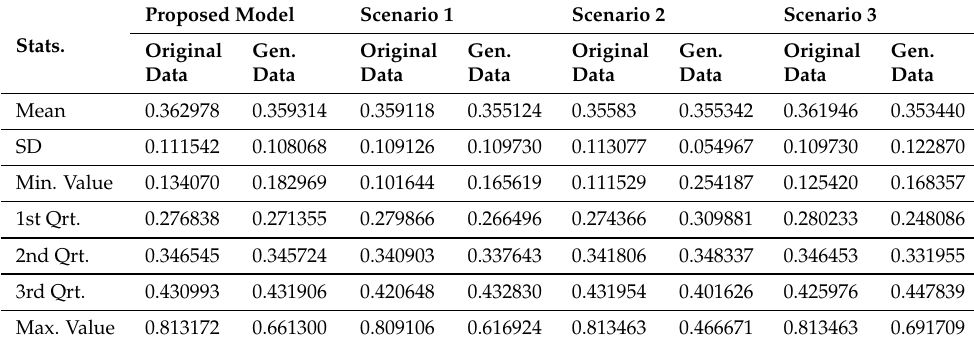
Table 8. Statistical Comparison-1.